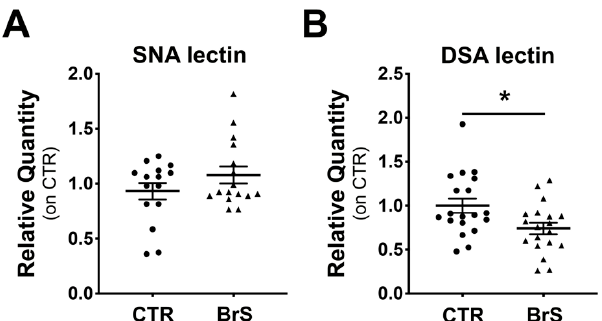
Figure 4. Plasma proteins showed a reduction in desialylation in BrS patients. Sialylation and desialylation status of the plasma proteins was analyzed through Western Blot followed by incubation with SNA and DSA lectins, respectively. ( A ) Total plasma sialylation levels. ( B ) Total plasma desialylation levels. CTR: N = 19, BrS: N = 19. Data represent the median ± SEM and are expressed as relative amounts compared with healthy controls. Each dot and triangles in the graphs represent a single healthy control and a single BrS patient, respectively. Statistical significance was determined by Student’s t -test. * p <